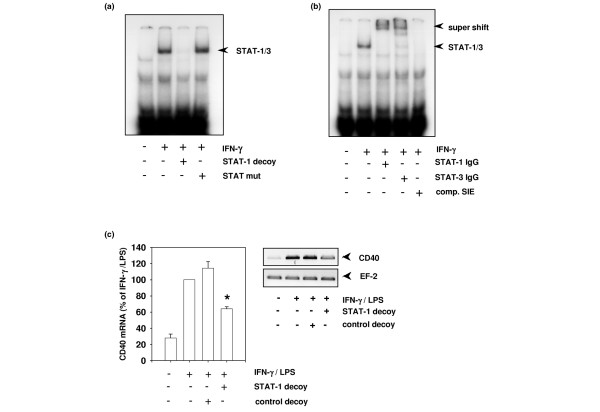
Efficacy of the STAT-1 decoy oligodeoxynucleotide (ODN) treatment in synoviocytes and macrophages in vitro. (a) Electrophoretic mobility shift analysis with extracts from synoviocytes stimulated by IFN-γ (250 U/ml, 30 minutes) and pre-treated (4 h before stimulation) with STAT-1 decoy ODN or STAT mutant ODN (STAT mut; 10 μM each). (b) Activation of STAT-1 and STAT-3 in IFN-γ-stimulated synoviocytes (250 U/ml IFN-γ, 30 minutes) was confirmed by gel shift supershift analysis with specific IgG antibodies. In addition, a 100-fold excess of the unlabelled compensatory sis-inducible element (comp. SIE) gel shift ODN abolished the STAT band, thus verifying the specificity of the detected band. (c) Statistical summary of the effect of STAT-1 decoy ODN (10 μM, 4 h pre-incubation) on CD40 mRNA expression in LPS/IFN-γ (1 μg/ml LPS plus 500 U/ml INF-γ)-stimulated RAW-264.7 macrophages after 12 h (n = 3 to 4, *P ≤ 0.05 versus LPS/IFN-γ). The mutant control ODN had no effect on CD40 expression. The insert shows a representative RT-PCR analysis (amplification of elongation factor-2 (EF-2) cDNA served as an internal standard).